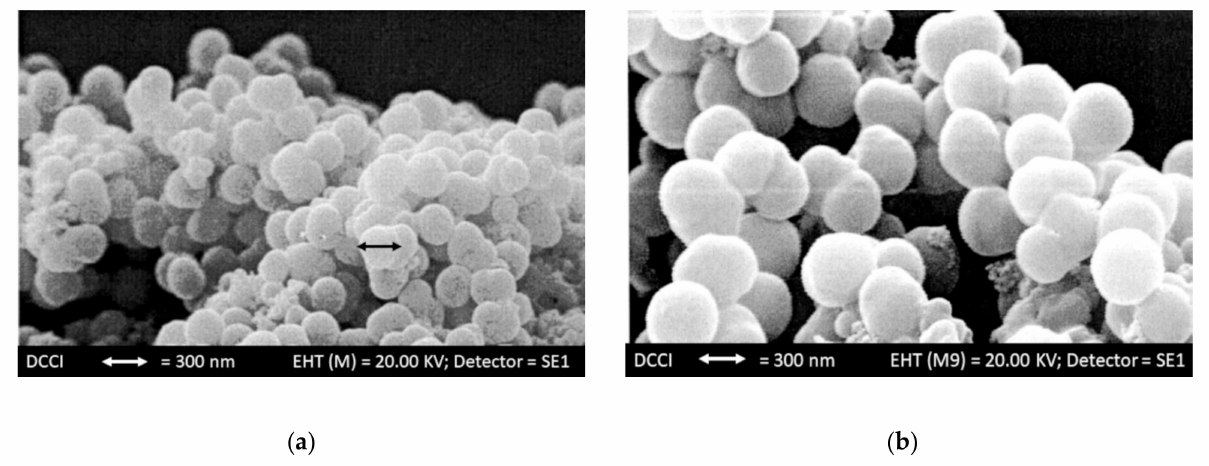
Figure 7. Scanning electron microscopy (SEM) images of G4K ( a ) and UA-G4K ( b )